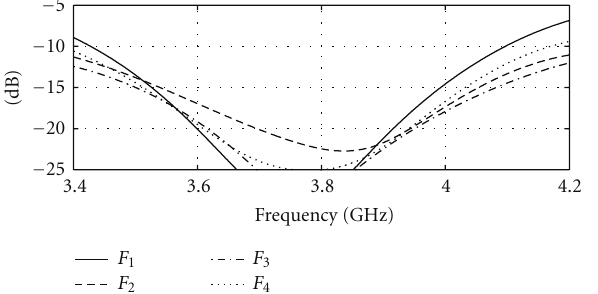
Figure 6: Simulated reflected field at each feed point of the antenna.